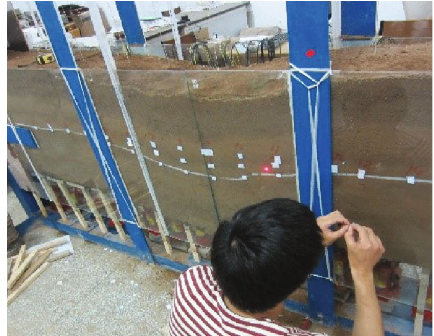
Figure 4: Observation of settlement of soil in pipeline